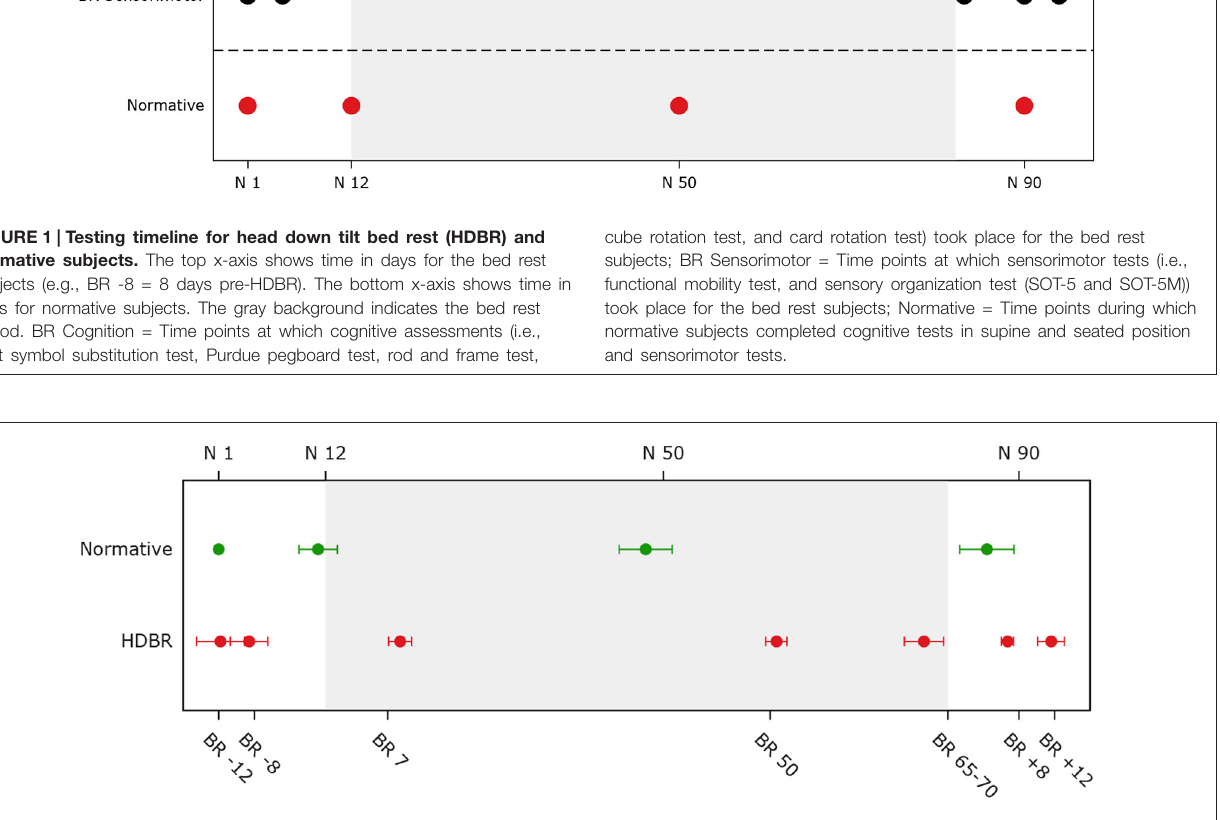
days pre-HDBR). The gray background indicates the bed rest period. Error bars represent standard deviations; Normative = normative control subjects ( n = 9); HDBR = head down bed rest subjects ( n =